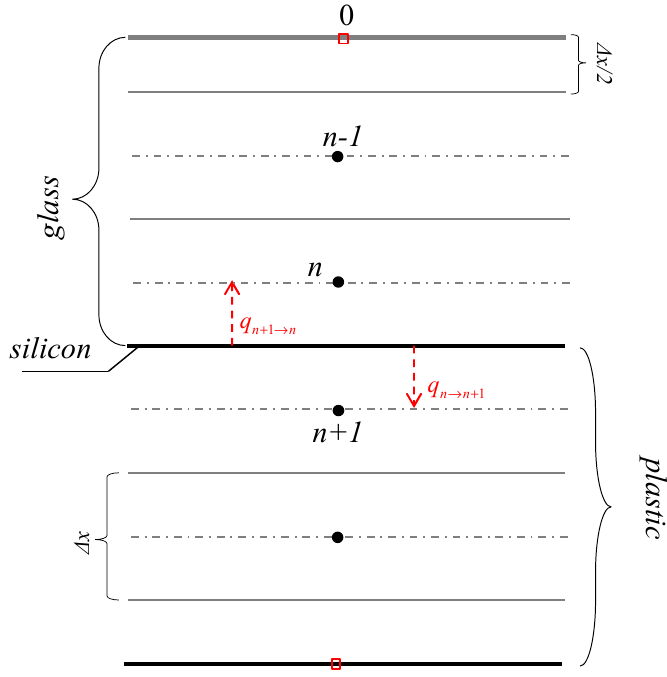
Figure 3. Scheme of spatial discretization of PV-PCM